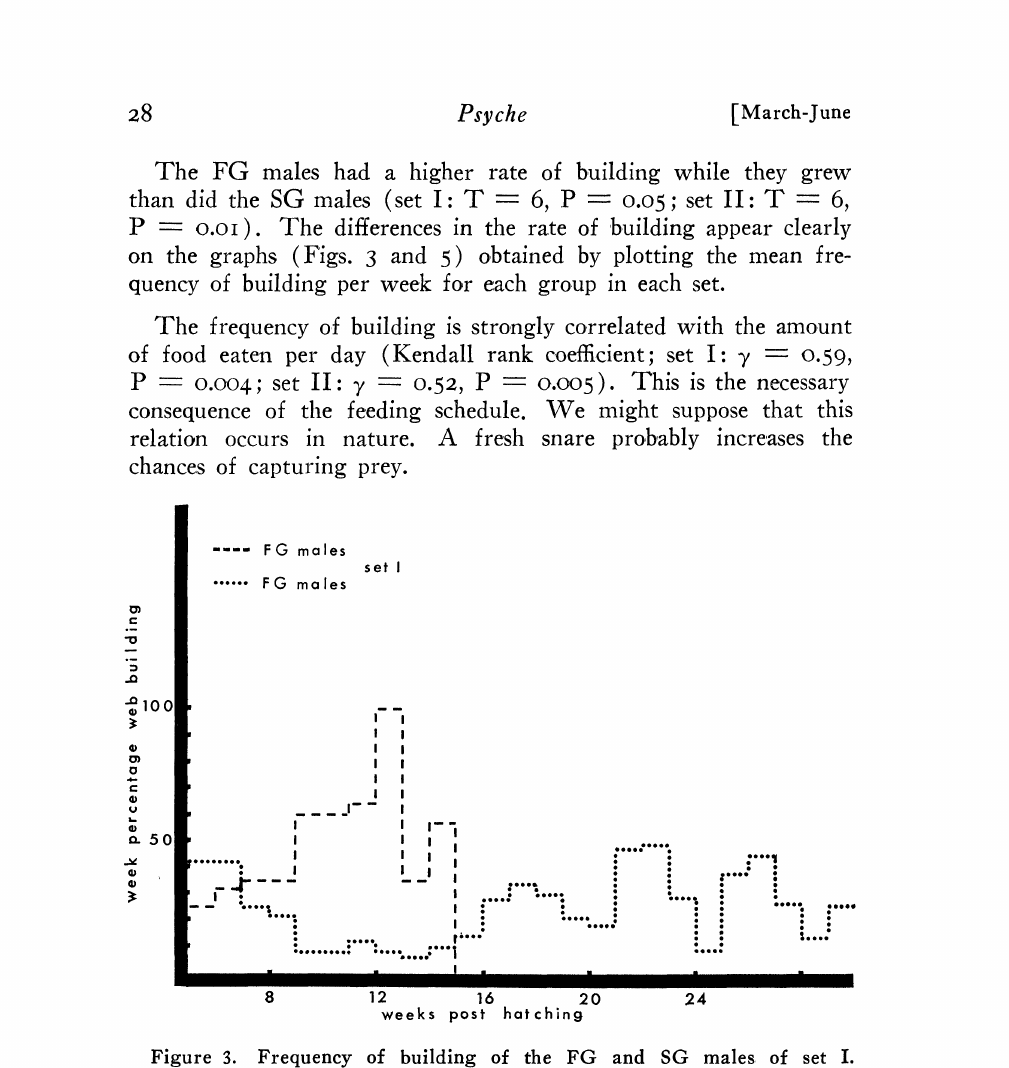
Figure 3. Frequency of building of the FG and SG males, of set I. Dashed line: weekly mean ,of frequency of buildingfor the, four FG males. Dotted line: weekly mean of frequency of building for the seven SG males Note the similarity in the pattern between weight increase and web building frequency. (Compare with Fig.